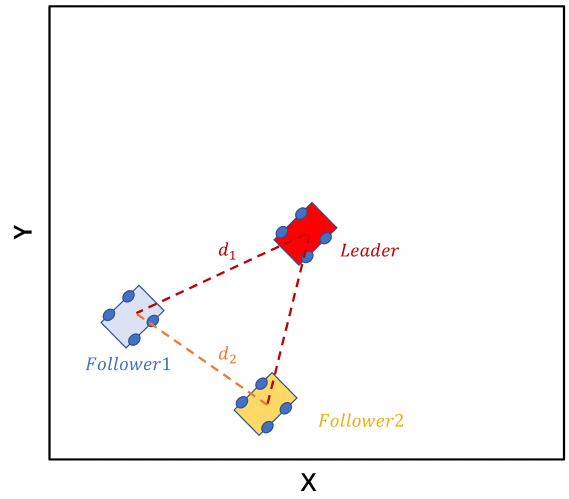
Figure 6. Illustration of the formation distance reward